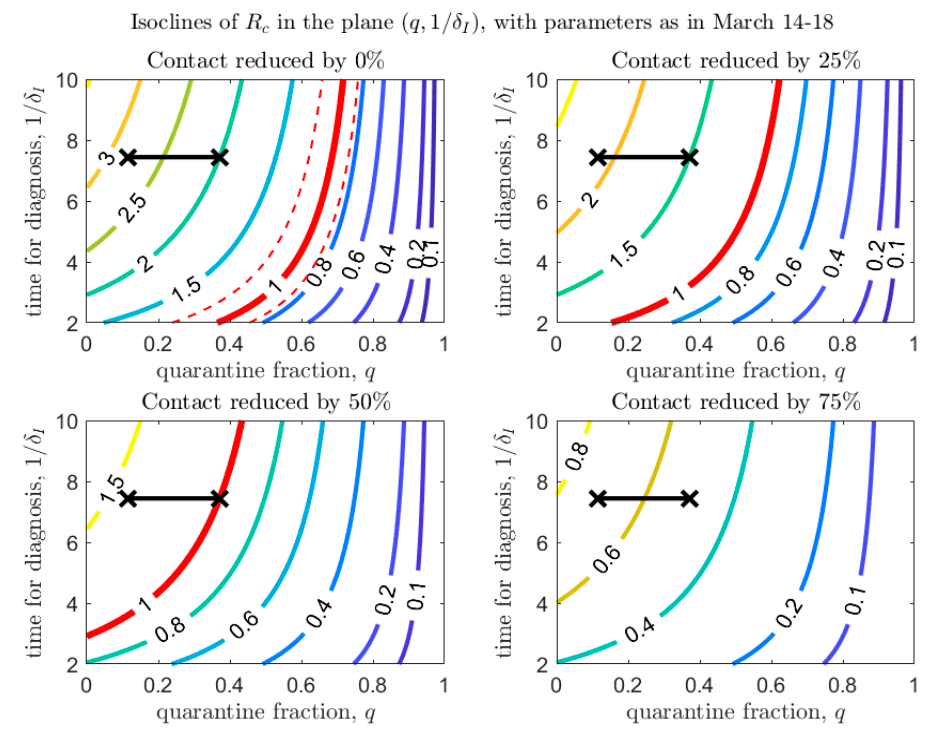
Figure 4. Values of 𝑅 (cid:3030) in the plane (𝑞, 1/𝛿 (cid:3010) ) , with baseline parameters estimated on March 24 (top- left panel), and under different scenarios of contact rate reduction (other panels). The red line corresponds to 𝑅 (cid:3030) = 1 (with dashed lines showing confidence intervals in the baseline scenario). The black crosses correspond to the parameters (max/min) estimated after March 24 (last day of the estimation period is April 21).